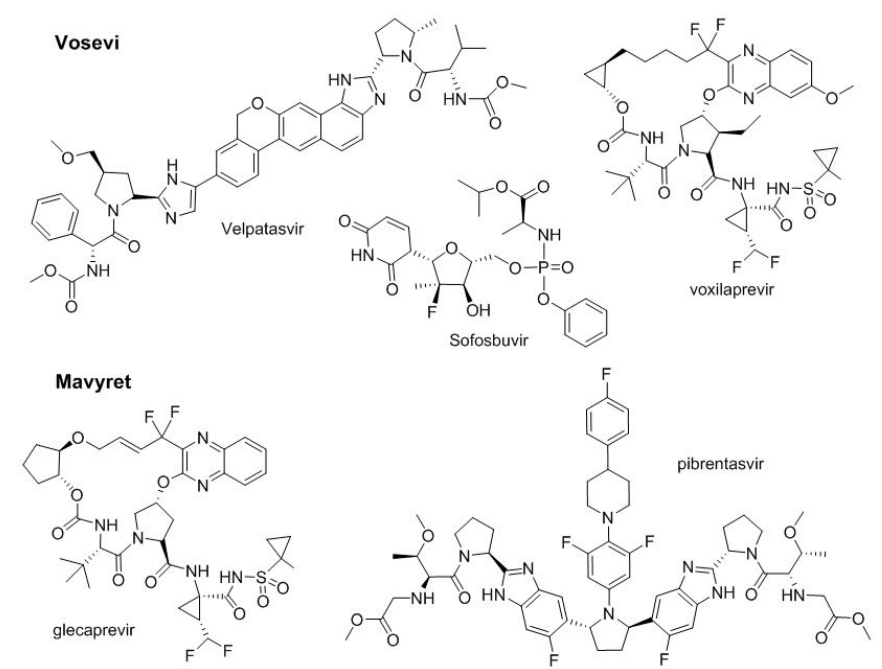
Figure 8. Structure of drug combination for treatment of hepatitis C.